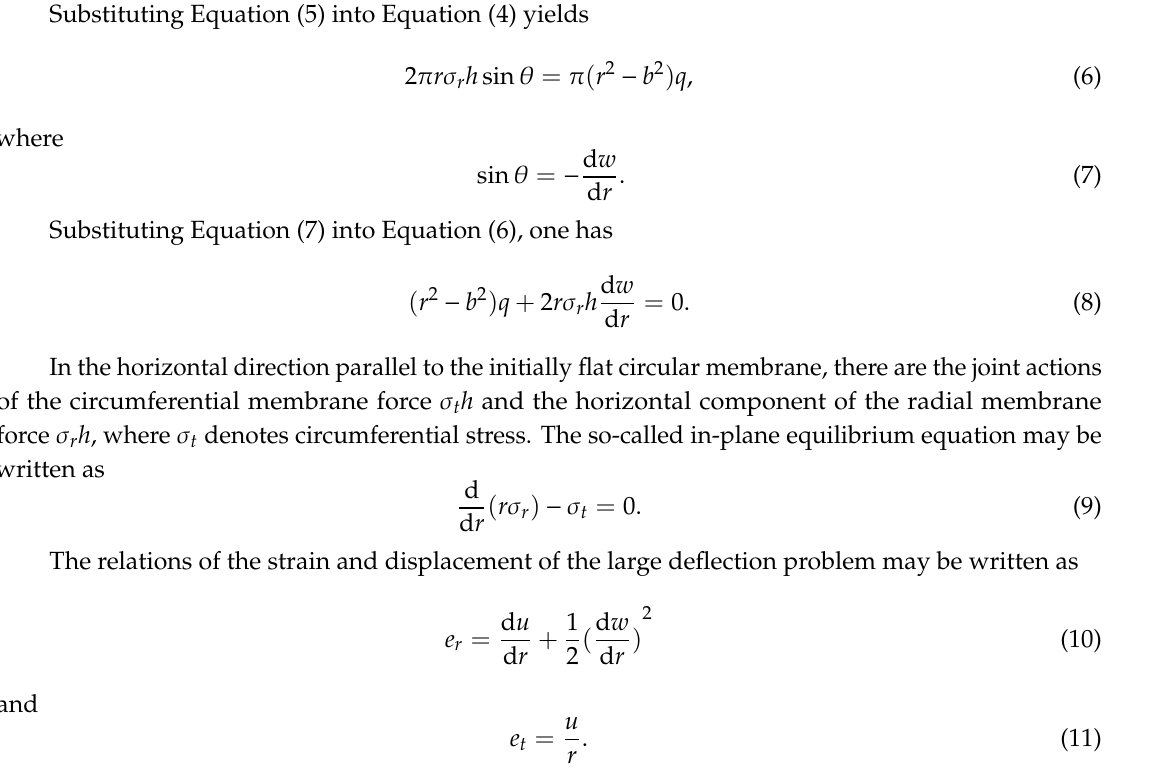
Figure 3. The free body diagram of the membrane within b ≤ r ≤ a .